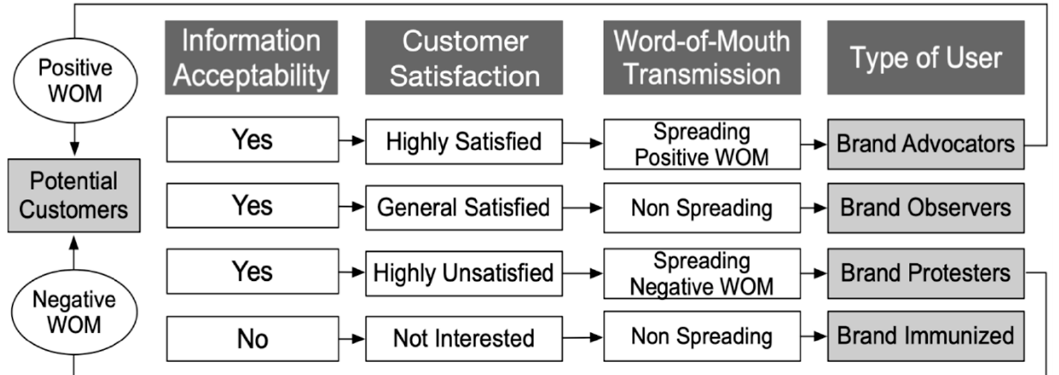
Figure 2. Evolutionary mechanism of the brand heterogeneous OWOM communication group in social media.